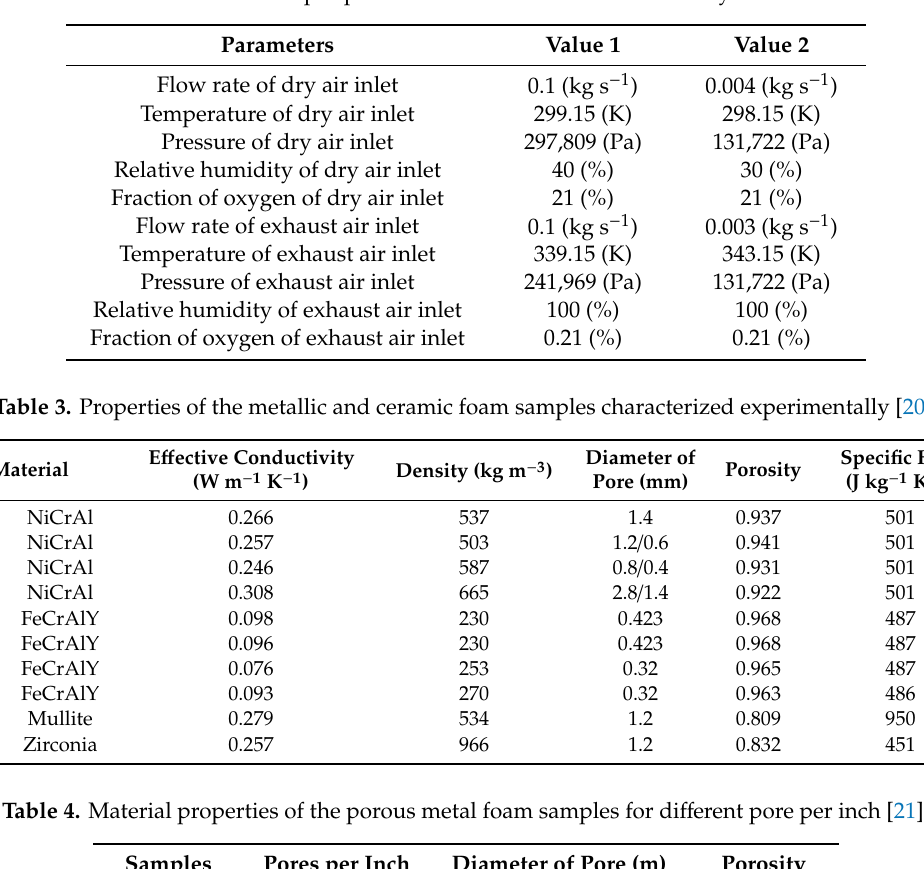
Table 2. Input parameters for simulation in this study.